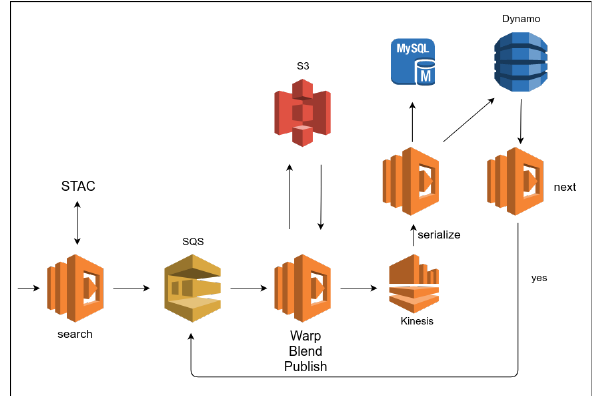
Figure 4: Brazil Data Cube generation service workflow on